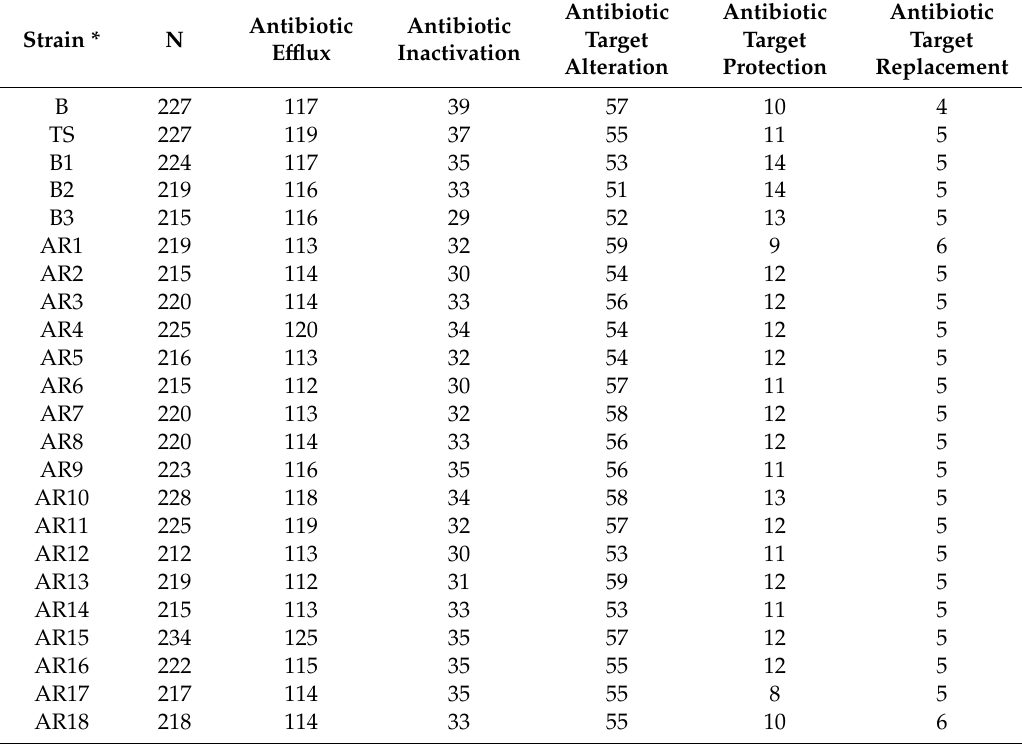
Table 2. Number of potential antibiotic resistance genes involved in antibiotic resistance mechanisms detected for each SAR strain after querying the Comprehensive Antibiotic Resistance Database